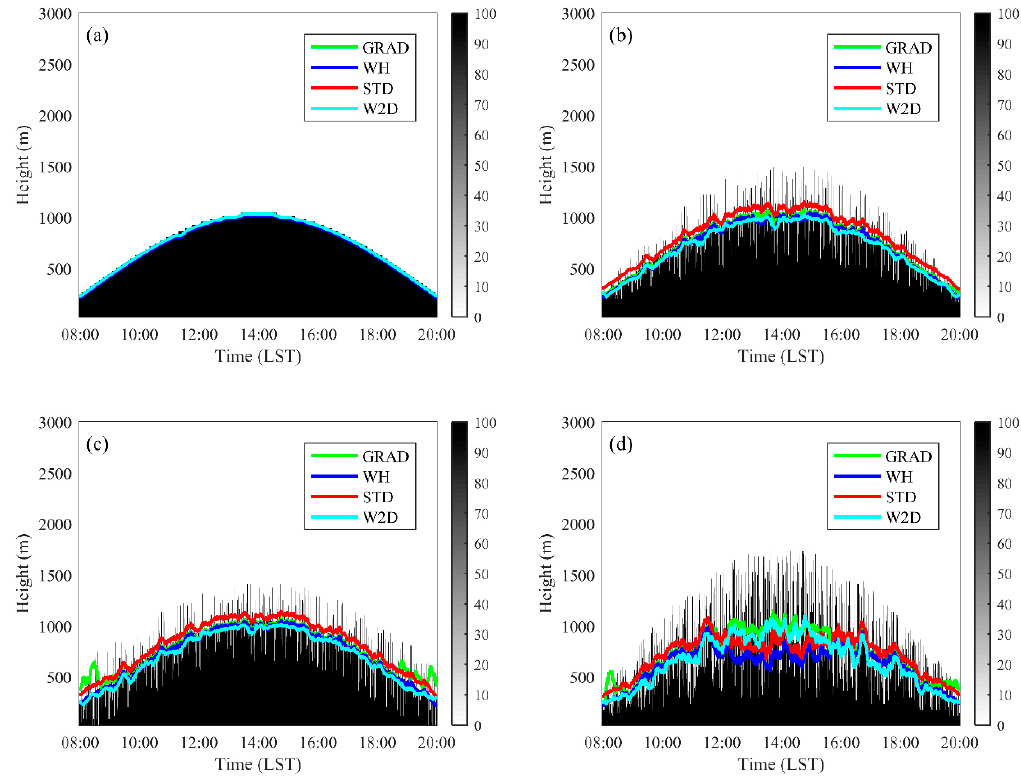
Figure 3. The ML heights estimated by different methods using ideal data: ( a ) the Case 0 experiment; ( b ) the Case 1 experiment; ( c ) the Case 2 experiment; and ( d ) the Case 3 experiment. Table 2. Evaluations of different methods using ideal data.